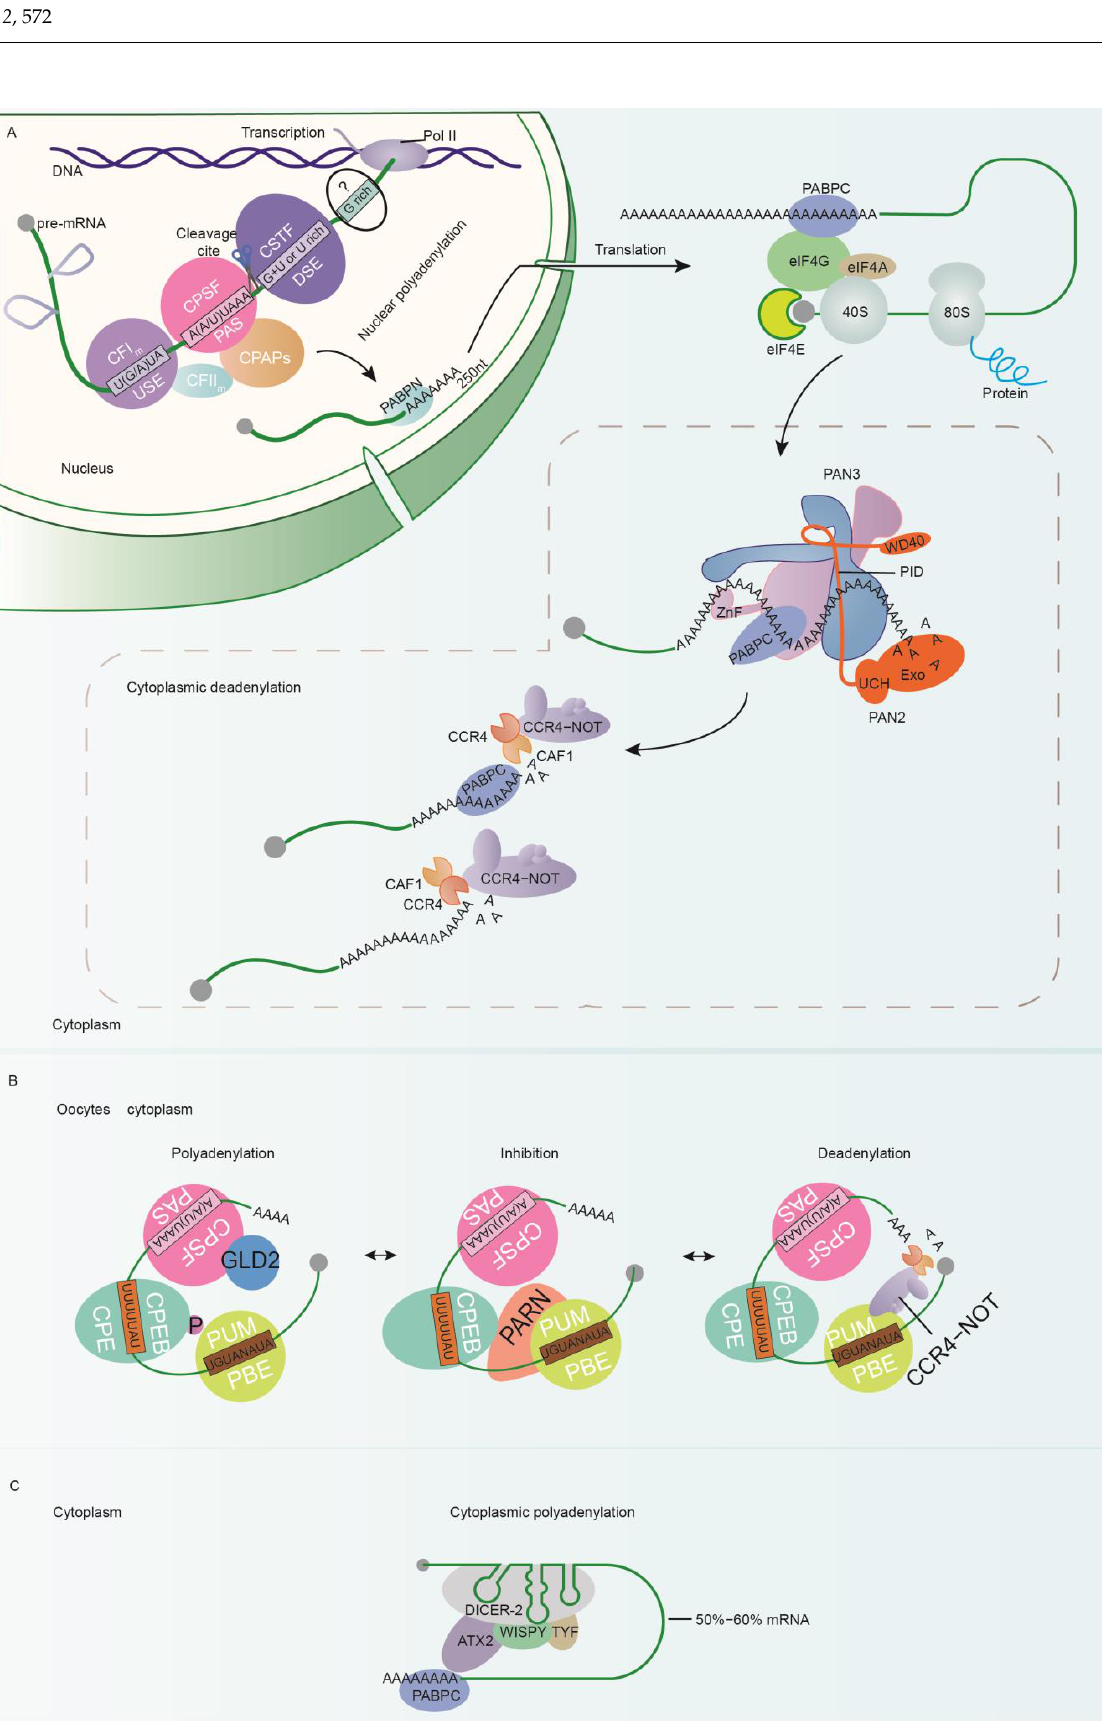
Figure 1. Schematic diagram of polyadenylation and deadenylation mechanisms. ( A ) In the nucleus, when nascent pre-mRNA is transcribed by Pol II, CPSF, CSTF, and CFIm complexes bind to